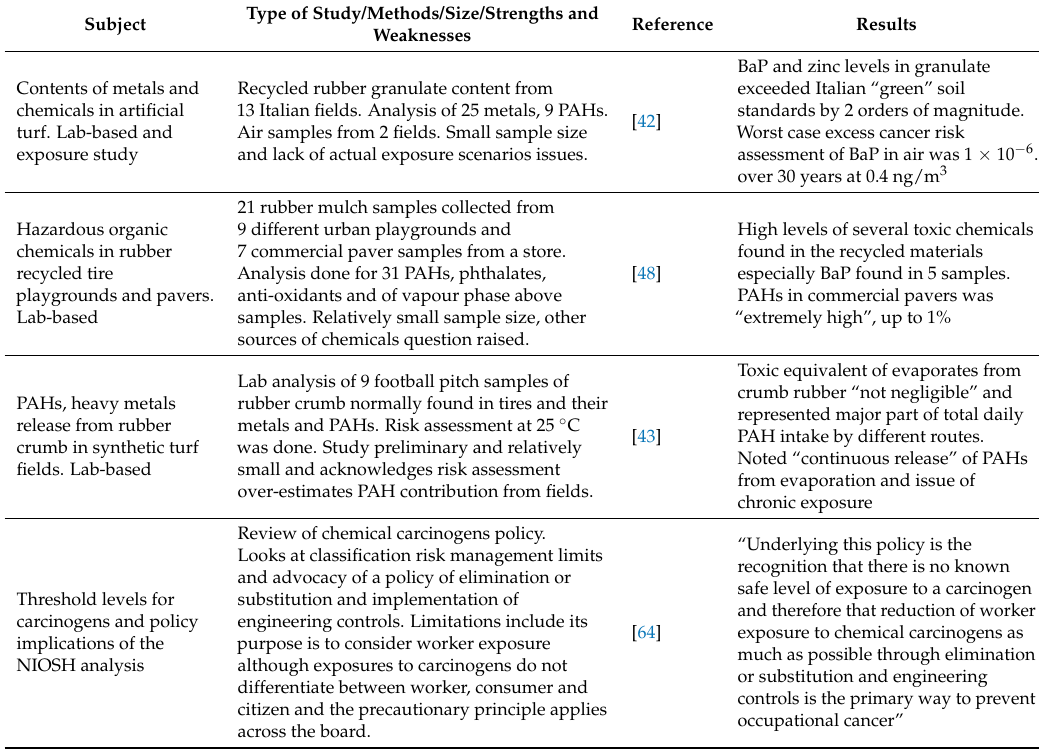
Table 2. Some studies/policy documents from the scientific literature indicating potential risk from crumb rubber on 3G pitches, commercial pavers and